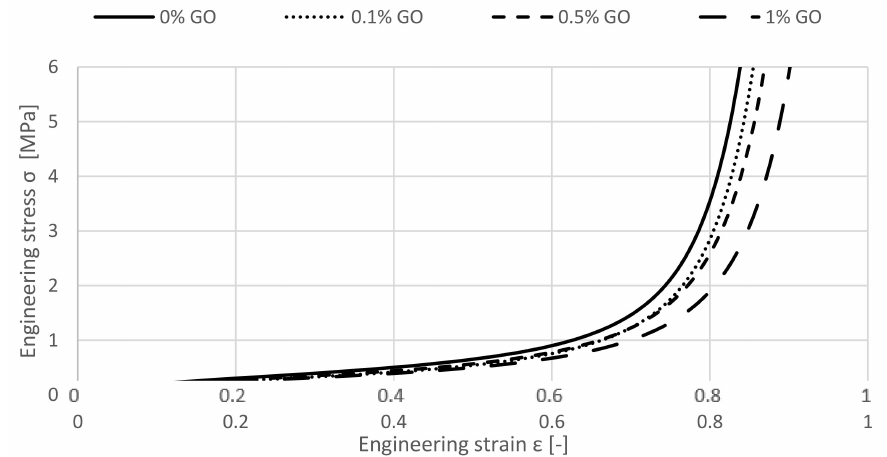
Figure 4. The influence of the GO used as a reinforcement on uniaxial quasi-static